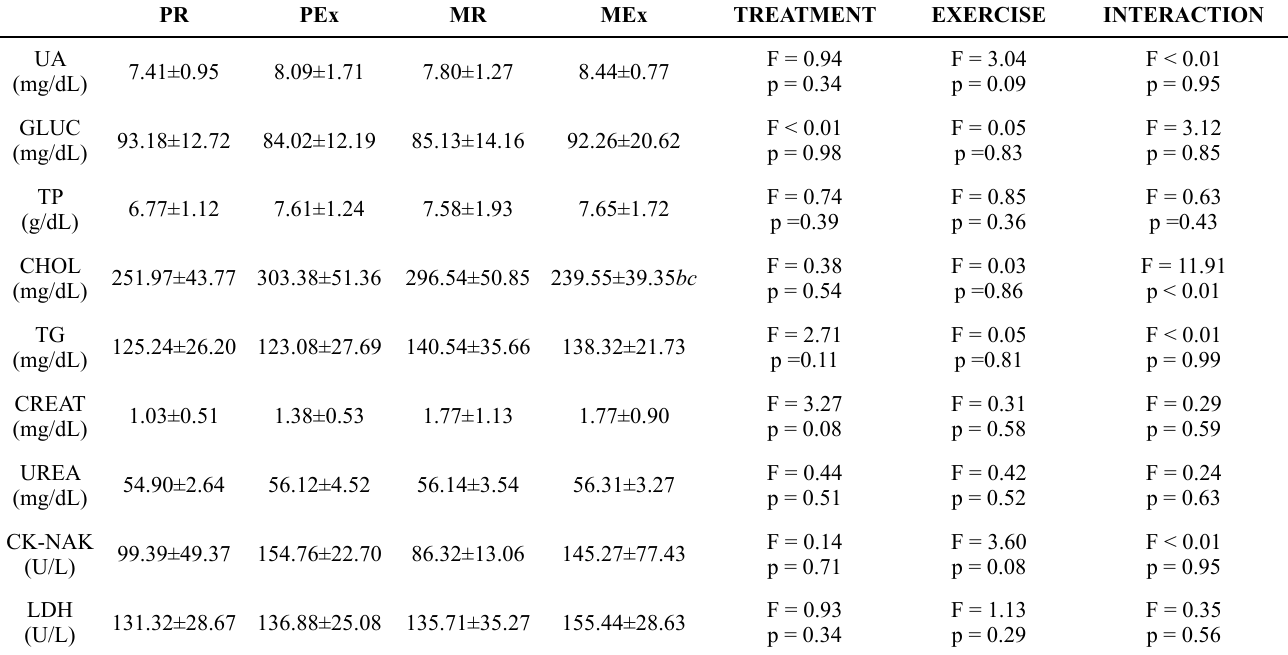
CHOL 251.97±43.77 303.38±51.36 296.54±50.85 239.55±39.35 (mg/dL)